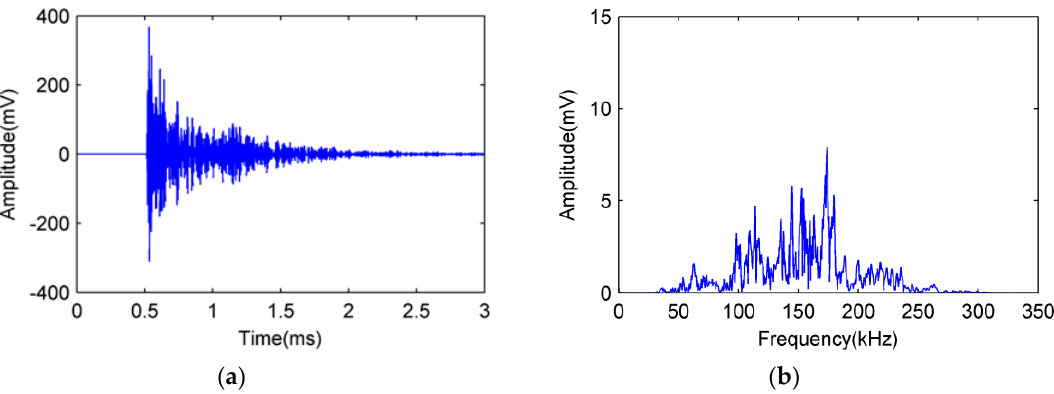
Figure 12. Broken lead signal detected by PZT R15 sensor. ( a ) Time domain diagram; ( b ) Frequency domain diagram.